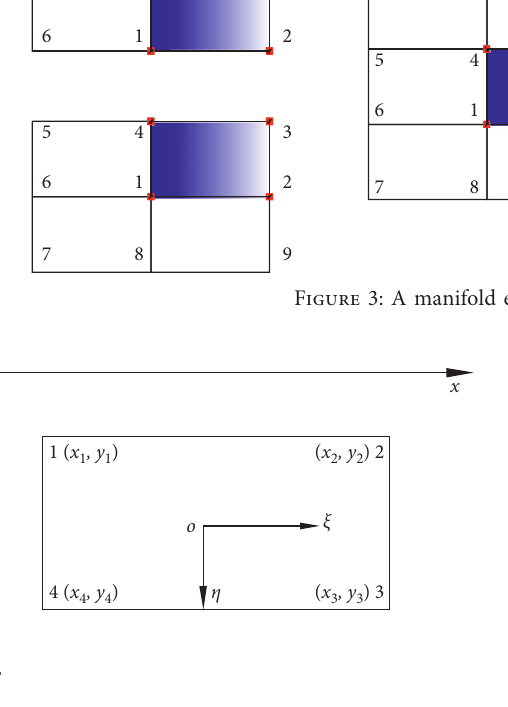
Figure 4: Global and local coordinate